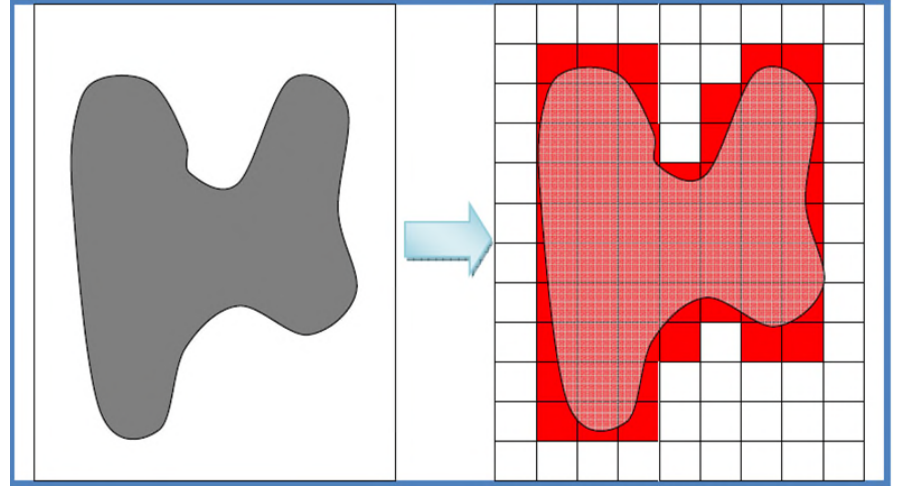
Figure 5. Discretization of the 3D space.